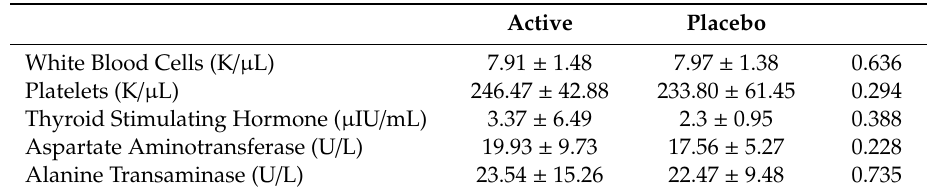
Table A1. Laboratory measurements at baseline for both groups.